Question: What does this figure show? Answer in one sentence.
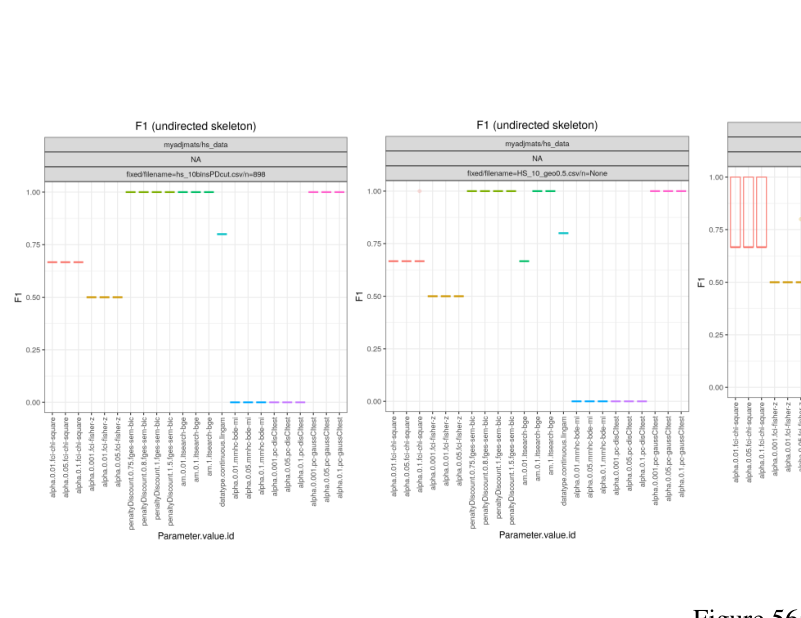
Answer: F1 Scores on the Human Stature data set. Dis- cretized, no noise.